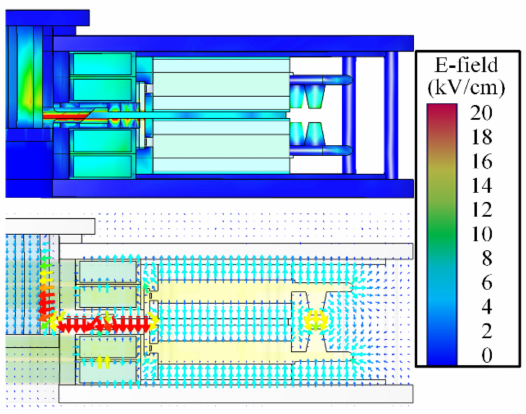
Figure 21. Cross-sectional view of the magnitude and vector diagram of electric field intensity at the instant of maximum load voltage.